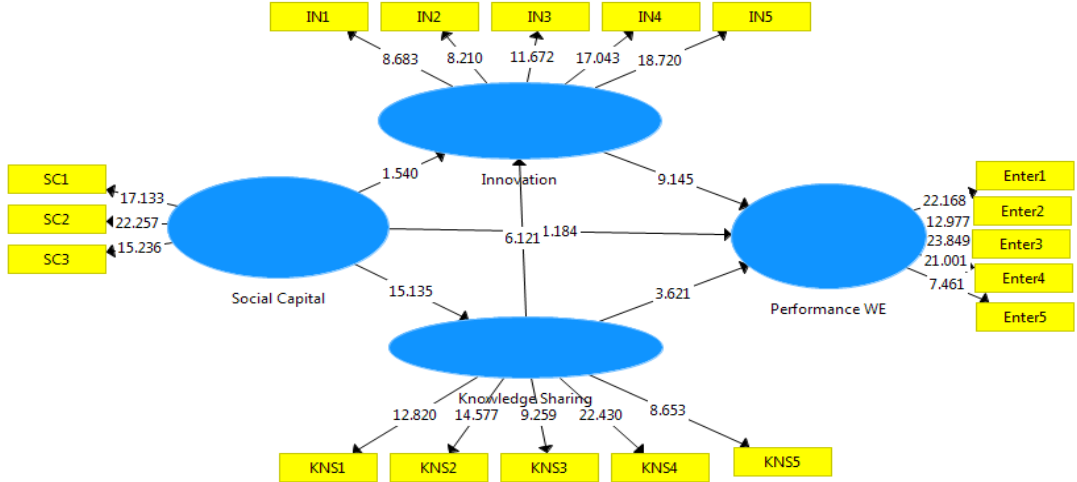
Table 3. Value Coefficients of R-square.